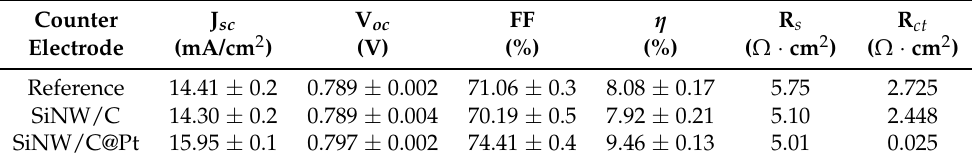
Figure 5. ( a ) Current–voltage ( J–V ) characteristics of the dye-sensitized solar cells (DSSCs) fabricated with reference (fluorine-doped tin oxide (FTO)/Pt), SiNW/C, and SiNW/C@Pt counter electrodes measured under 1 sun illumination (AM 1.5 G, 100 mW/cm 2 ); ( b ) equivalent circuit model of the symmetrical dummy cells consisting of the identical counter electrodes (CEs); ( c ) cyclic voltammograms; and ( d ) Nyquist plots of the symmetrical dummy cells. Table 1. Photovoltaic performance of the DSSCs fabricated with FTO/Pt, SiNW/C, and SiNW/C@Pt counter